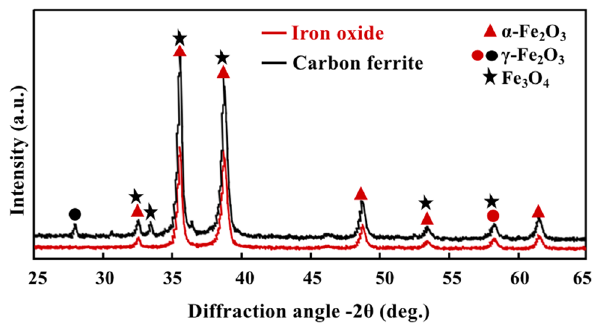
Figure 2. XRD patterns of iron oxide nanoparticles and carbon ferrite